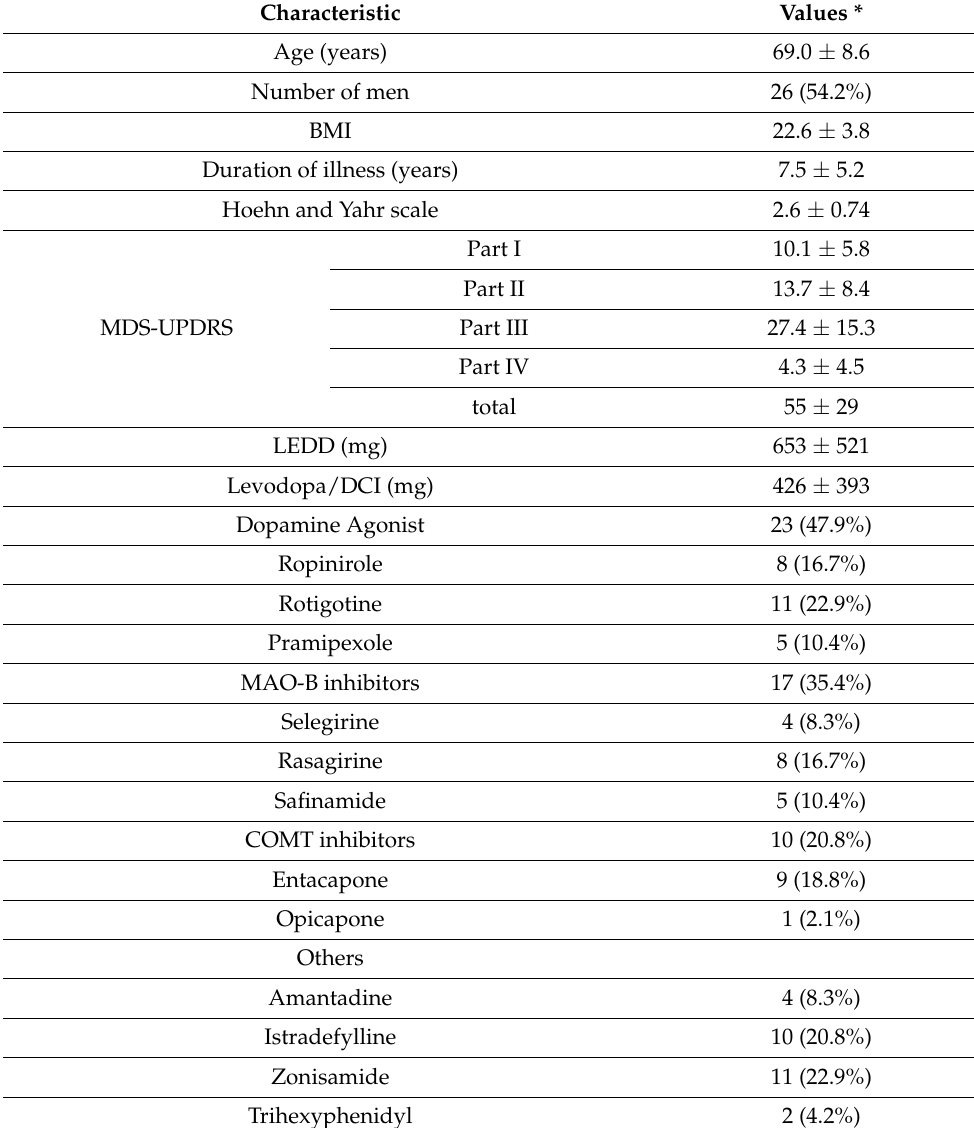
Table 1. Patient characteristics ( n =